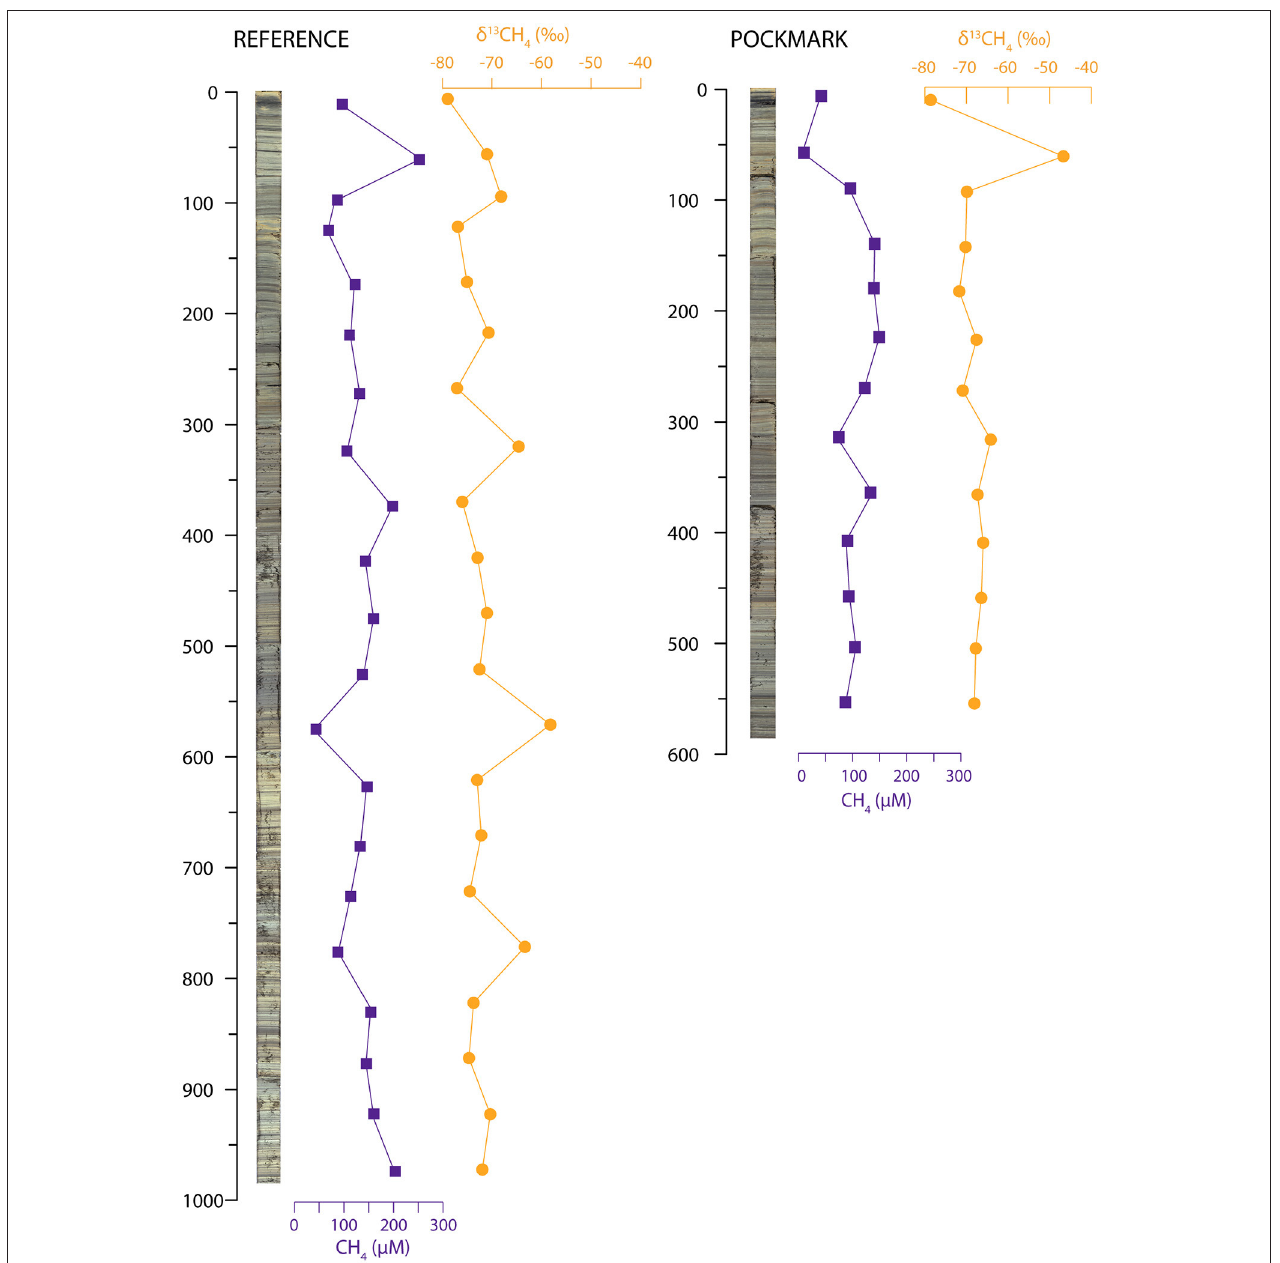
FIGURE 5 | Vertical profiles of CH 4 concentration and δ 13 CH 4 isotopic signature of sediment cores collected at the pockmark and reference sites of DPS.